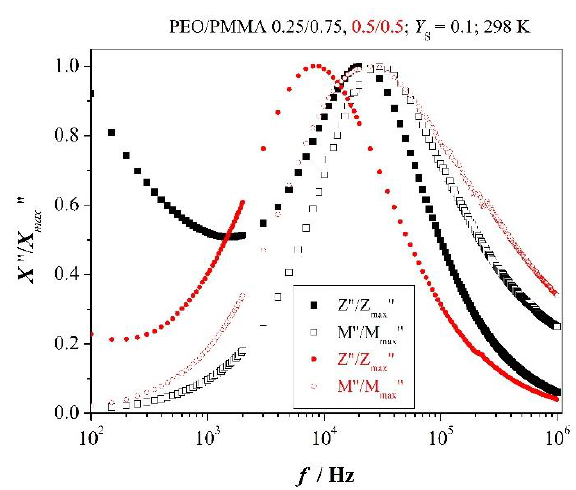
Figure 5. Scaled imaginary parts of impedance Z* and electric modulus M* ; scaled Z ”—solid marker, scaled M ”—open marker.